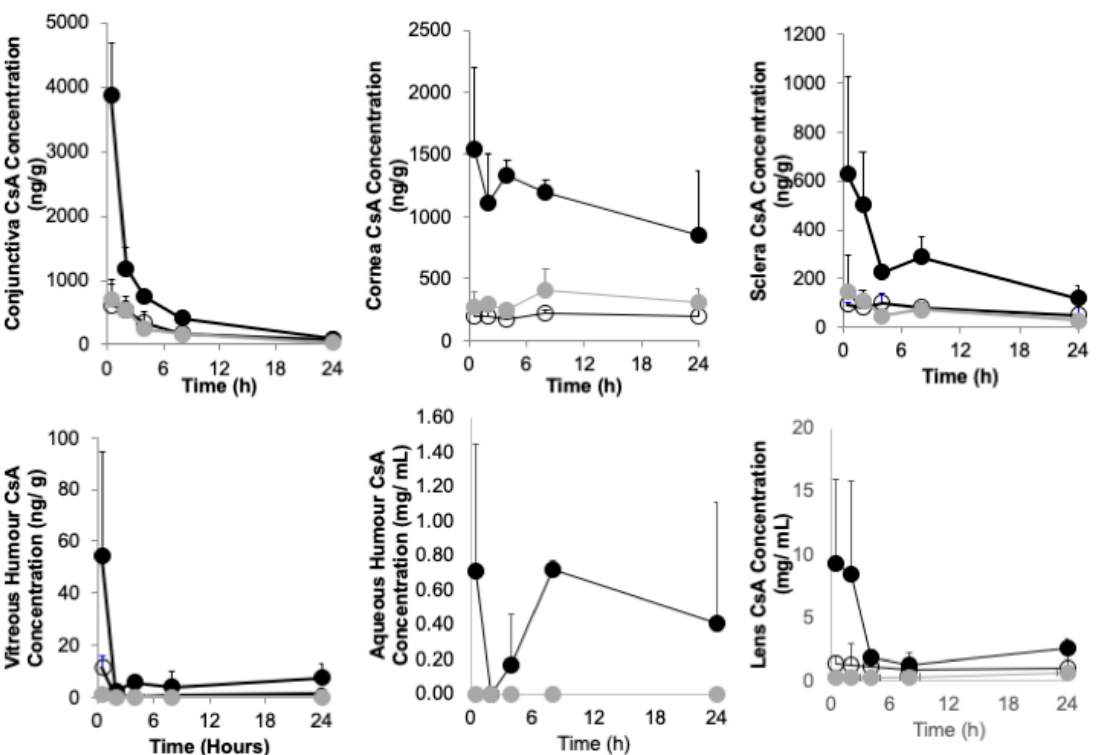
Figure 2. Ocular pharmacokinetics after the topical ocular dosing of NM133 and Restasis formulations to a healthy rabbit model (mean ± s.d., n = 3 per group); animals were dosed with a single dose of 25 µ L of NM133 0.05%A ( • ), 25 µ L of NM133 0.01%A ( • ) or 25 µ L of Restasis 0.05% emulsion ( ). NM133 0.05%A delivers significantly more CsA to the ocular tissues than Restasis ( p < 0.05). There was no plasma exposure to CsA with the NM133 formulations. (cid:35) Table 8. AUC 0–24 in selected tissues following the topical ocular dosing of NM133 and Restasis formulations *.